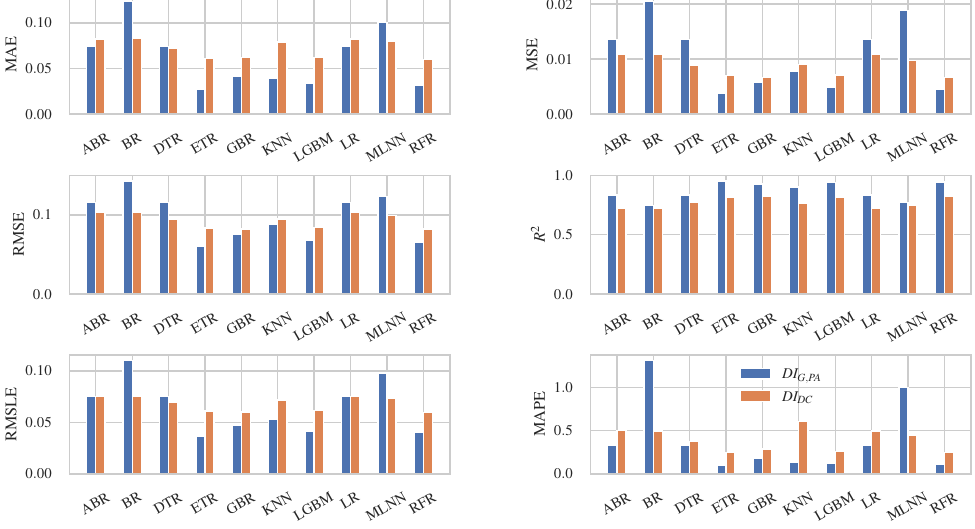
Figure 8. Peformace metrics of the examined